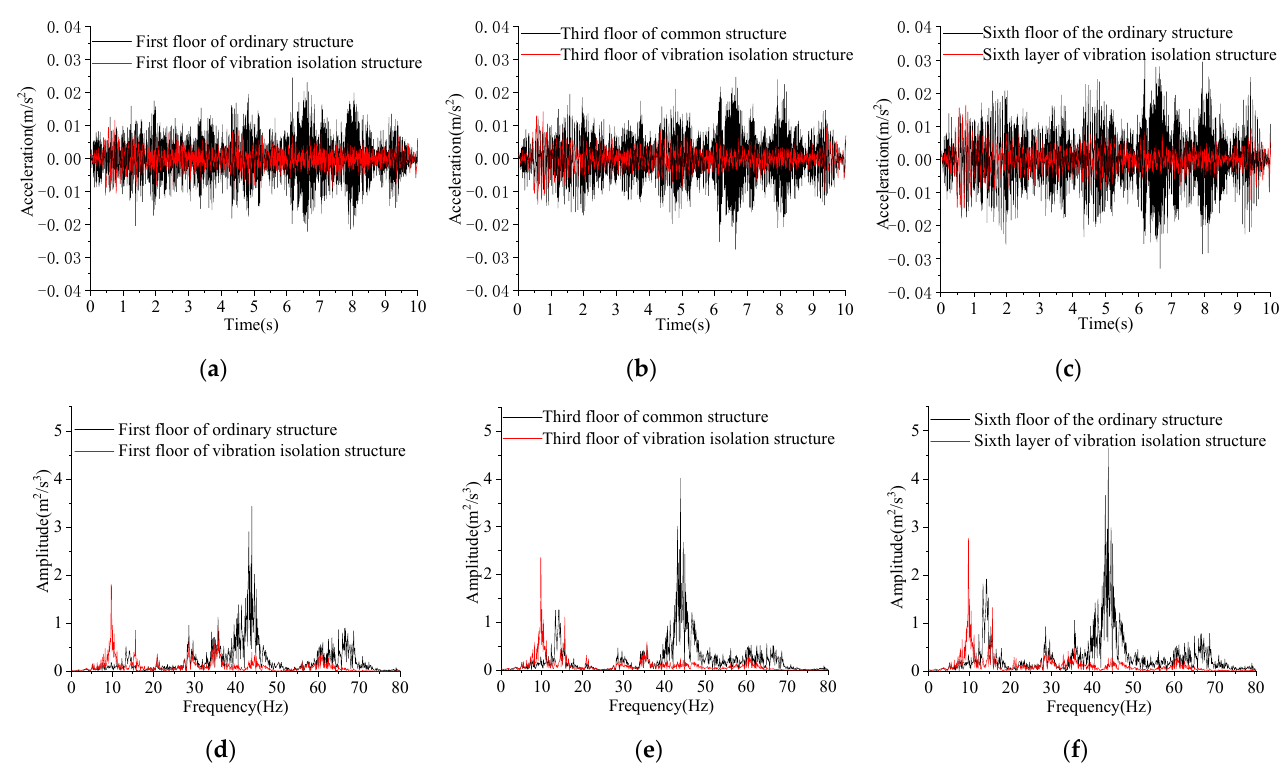
Figure 15. Structural vibration response: ( a ) vertical acceleration of the first floor; ( b ) vertical acceleration of the third floor; ( c ) vertical acceleration of the sixth floor; ( d ) spectra of the first floor; ( e ) spectra of the third floor; ( f ) spectra of the sixth floor.